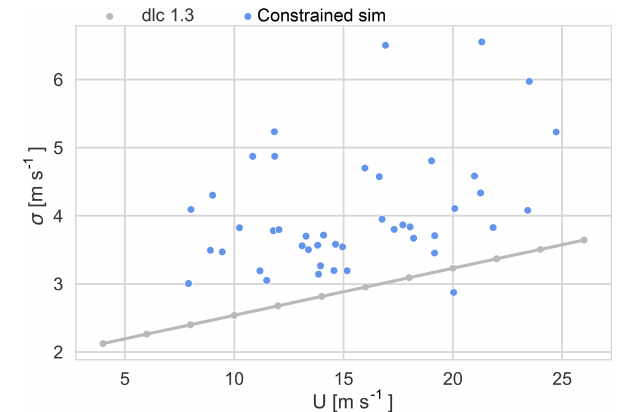
Figure 8. The mean standard deviation of the u component of the simulated wind speed at hub height as a function of mean wind speed at hub height. DLC 1.3 (grey dots) and constrained simula- tions with extreme variance events (blue